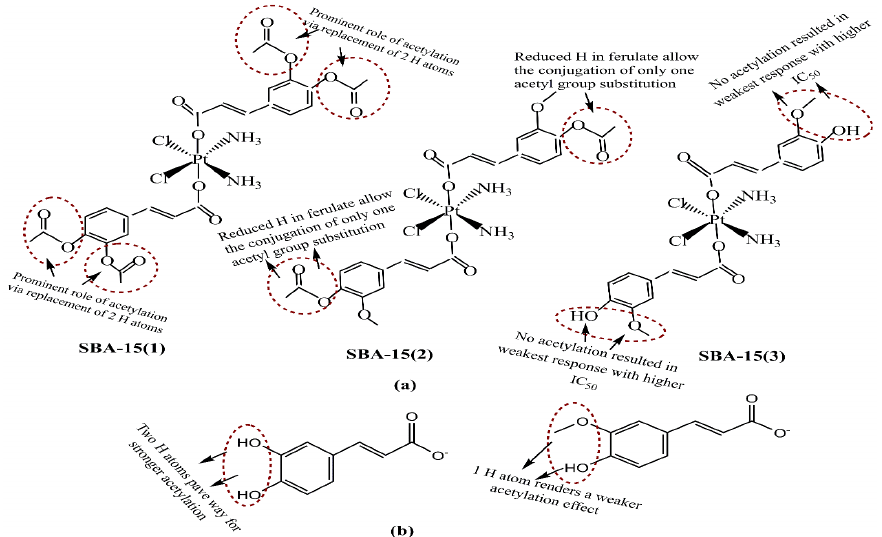
Figure 15. ( a ) Structural distinctions of acetylated caffeate and ferulate, with SBA-15(1) exhibiting the highest impact for acetylation and, hence, the anticancer efficacy, as opposed to SBA-15(3), for which the maximum IC 50 were noticed. ( b ) Chemical structures of caffeate and ferulate.